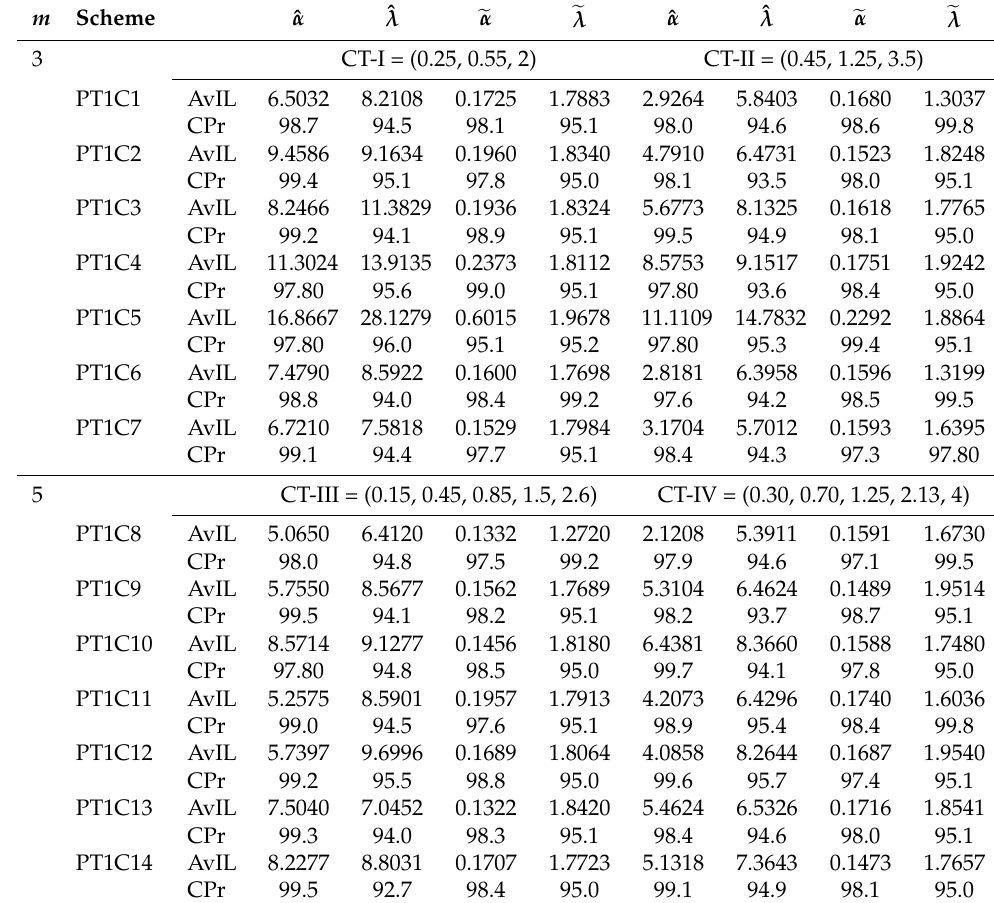
Table 5. AvILs and CPr(in %) values and MSErs of the ML and BEs for NH model with α = 0.5 and λ = 1.5 under various censoring schemes at n = 25.